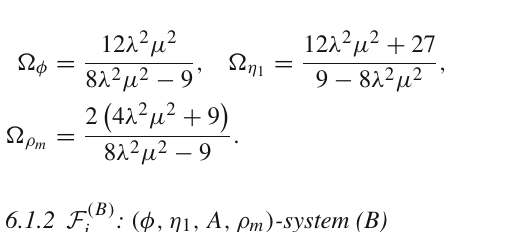
and (cid:12) ρ , m 1